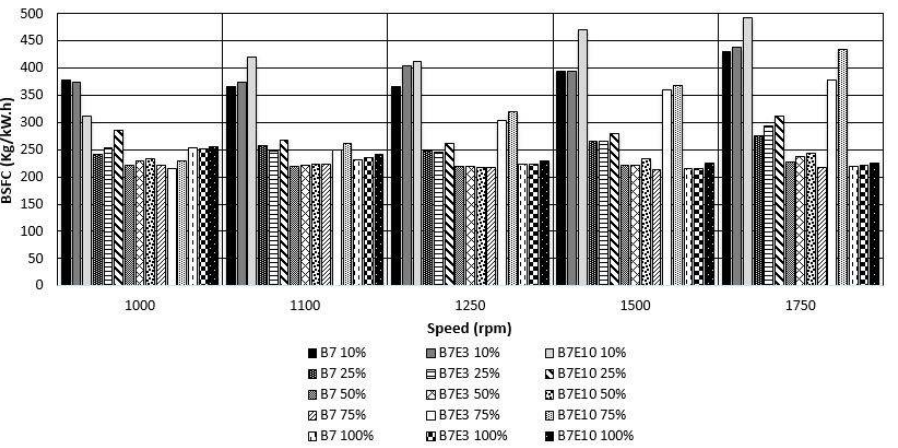
Figure 5. BSFC of the fuel blends for each operation condition in the diesel engine.